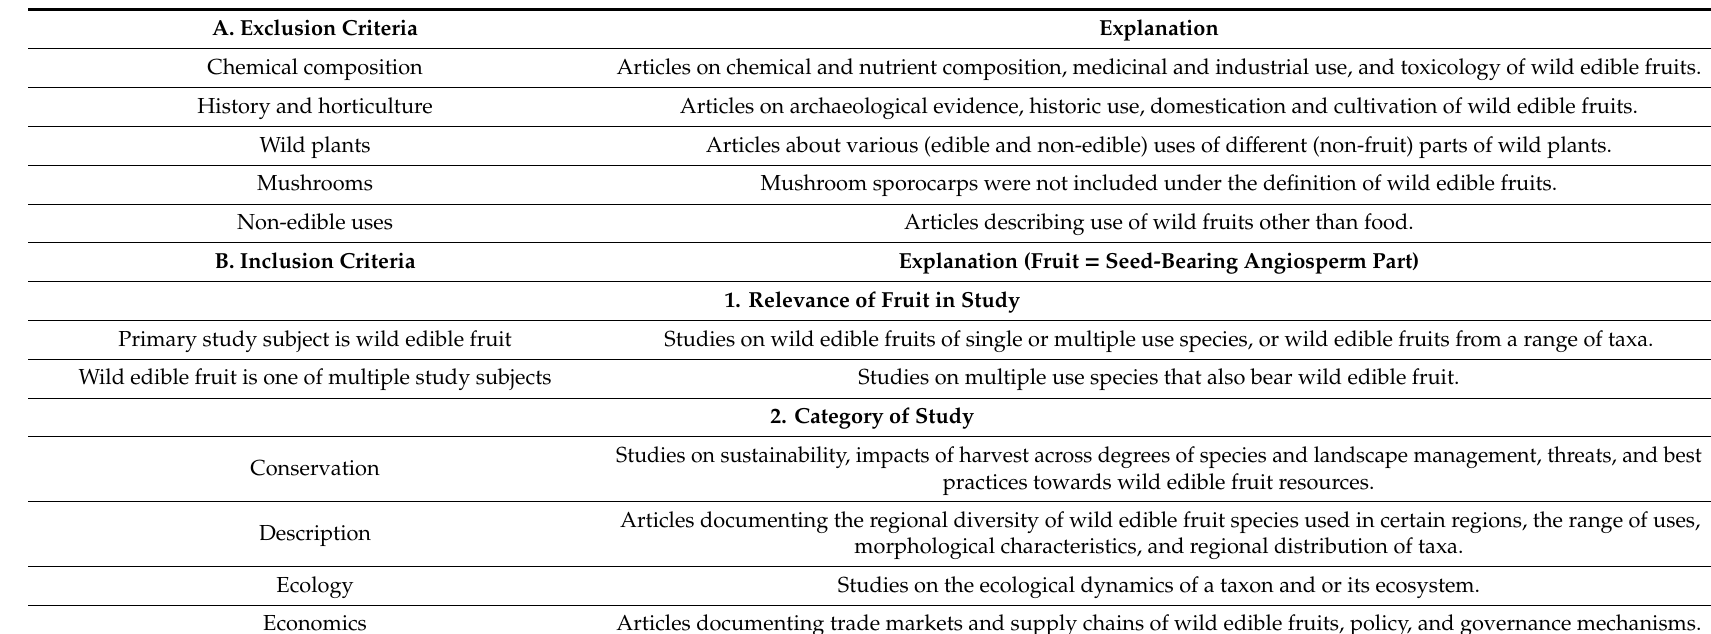
Table 1. Selection and classification criteria for